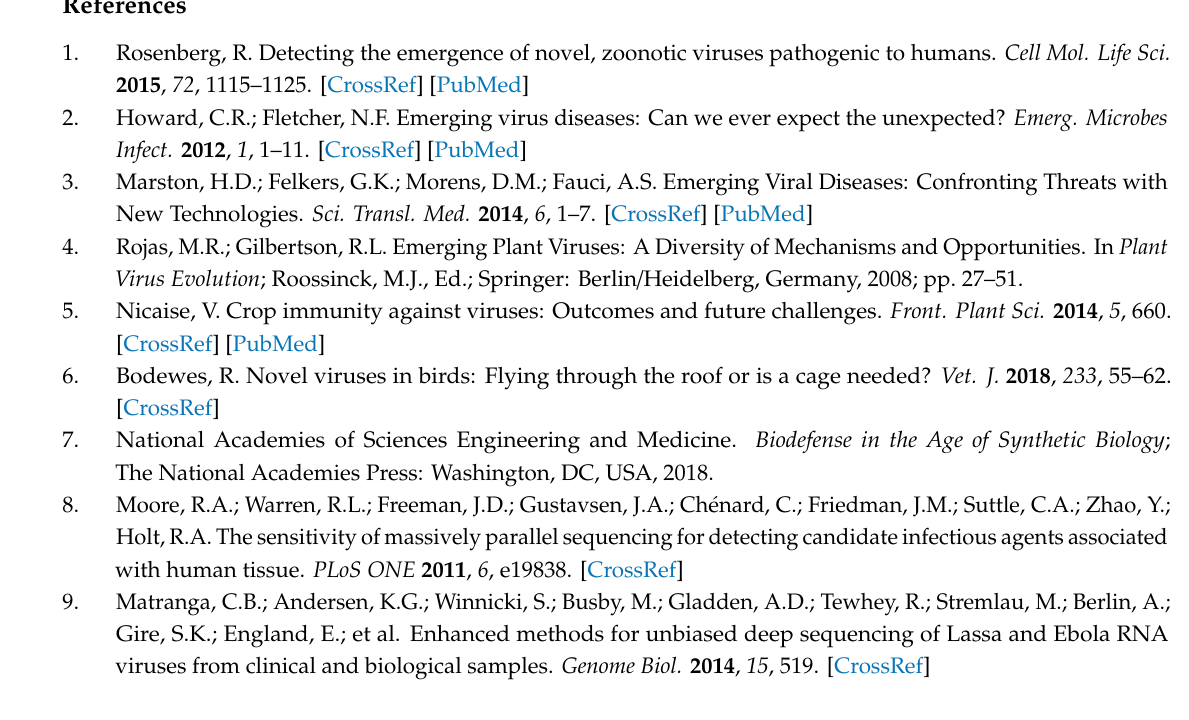
Figure S1: Immunoblot analysis of total RNA samples using anti-dsRNA antibody., Figure S2: Analysis of dsRNA purification method., Figure S3: Picorna-like viral contigs assembled from mouse dsRNA-Seq libraries are derived from single-stranded RNA., Figure S4: Mapping of dsRNA-Seq and RNA-Seq reads from boa constrictor kidney sample to host and viral sequences. Table S1: Summary of contigs assembled from dsRNA-Seq reads from Vero cell culture samples., Table S2: Summary of double stranded contigs assembled from dsRNA-Seq reads from mouse tissue samples., Table S3: Summary of dsRNA contigs assembled from dsRNA-Seq reads from reptile and mule deer tissue samples., File S1: Vero 1 contigs fasta file, File S2: Vero 2 contigs fasta file, File S3: Vero 3 contigs fasta file, File S4: Mouse 1 contigs fasta file, File S5: Mouse 2 contigs fasta file, File S6: Mouse 3 contigs fasta file, File S7: Mouse 4 contigs fasta file, File S8: Mouse 5 contigs fasta file, File S9: Green Tree Python Lung dsRNA contigs fasta file, File S10: Green Tree Python Lung Esophagus dsRNA contigs fasta file, File S11: Rough Scaled Python Lung dsRNA contigs fasta file, File S12: Boa Constrictor Kidney dsRNA contigs fasta file, File S13: Veiled Chameleon Lung Trachea Oral Mucosa dsRNA contigs fasta file, File S14: Veiled Chameleon Lung Liver Kidney 1 dsRNA contigs fasta file, File S15: Veiled Chameleon Lung Liver Kidney 2 dsRNA contigs fasta file, File S16: Mule Deer Brain dsRNA contigs fasta file, File S17: Mule Deer Lymph Node dsRNA contigs fasta file, File S18: Negative Control dsRNA contigs fasta